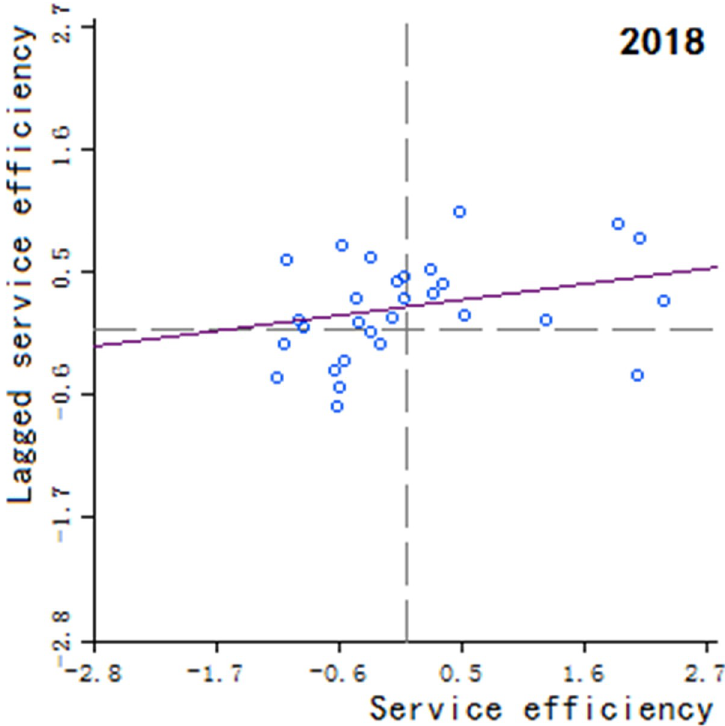
Fig 9. Scatter plot of China’s regional medical and health service level distribution from 2004 to 2018. https://doi.org/10.1371/journal.pone.0252871.g009 PLOS ONE | https://doi.org/10.1371/journal.pone.0252871 July 22,